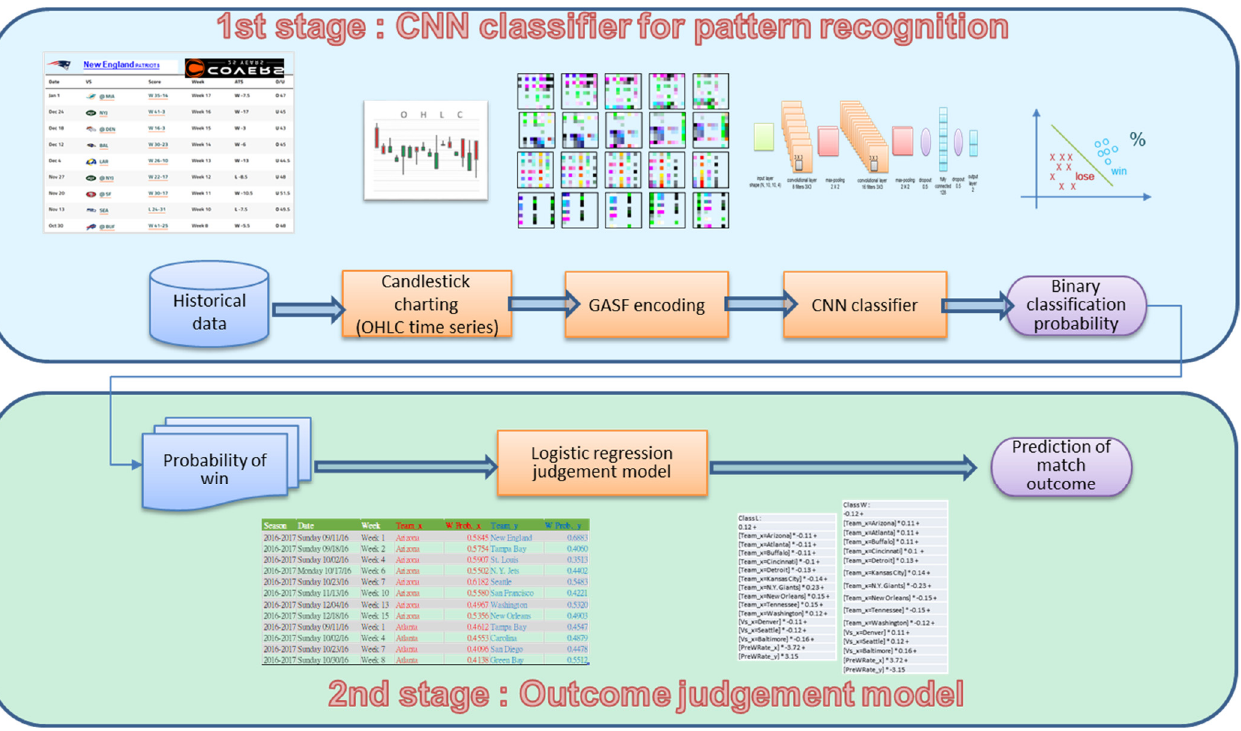
Figure 1. The framework of the proposed two-stage approach for sports outcome prediction model.